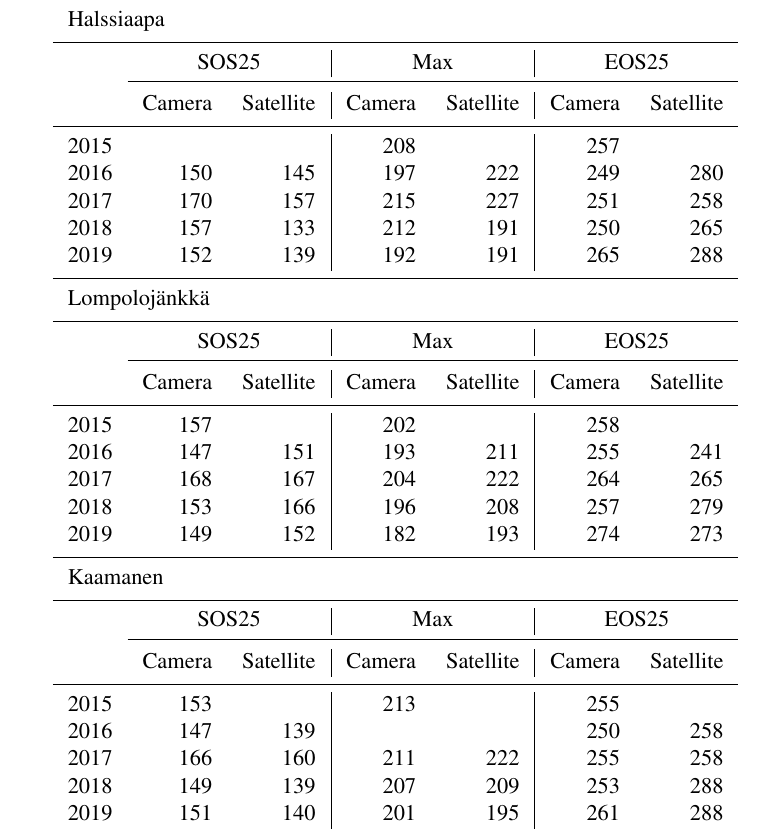
Table 6. Growing season phases estimated from camera and satellite images (DOY): SOS25 (start of season, 25% difference between start and maximum), Max (maximum GCC) and EOS (end of season, 25% difference between end and